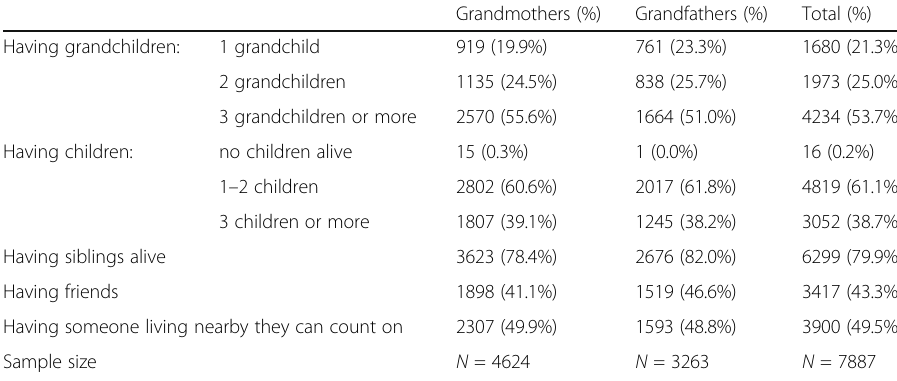
Table 2 Availability of family members and friends of grandparents aged 60 years or